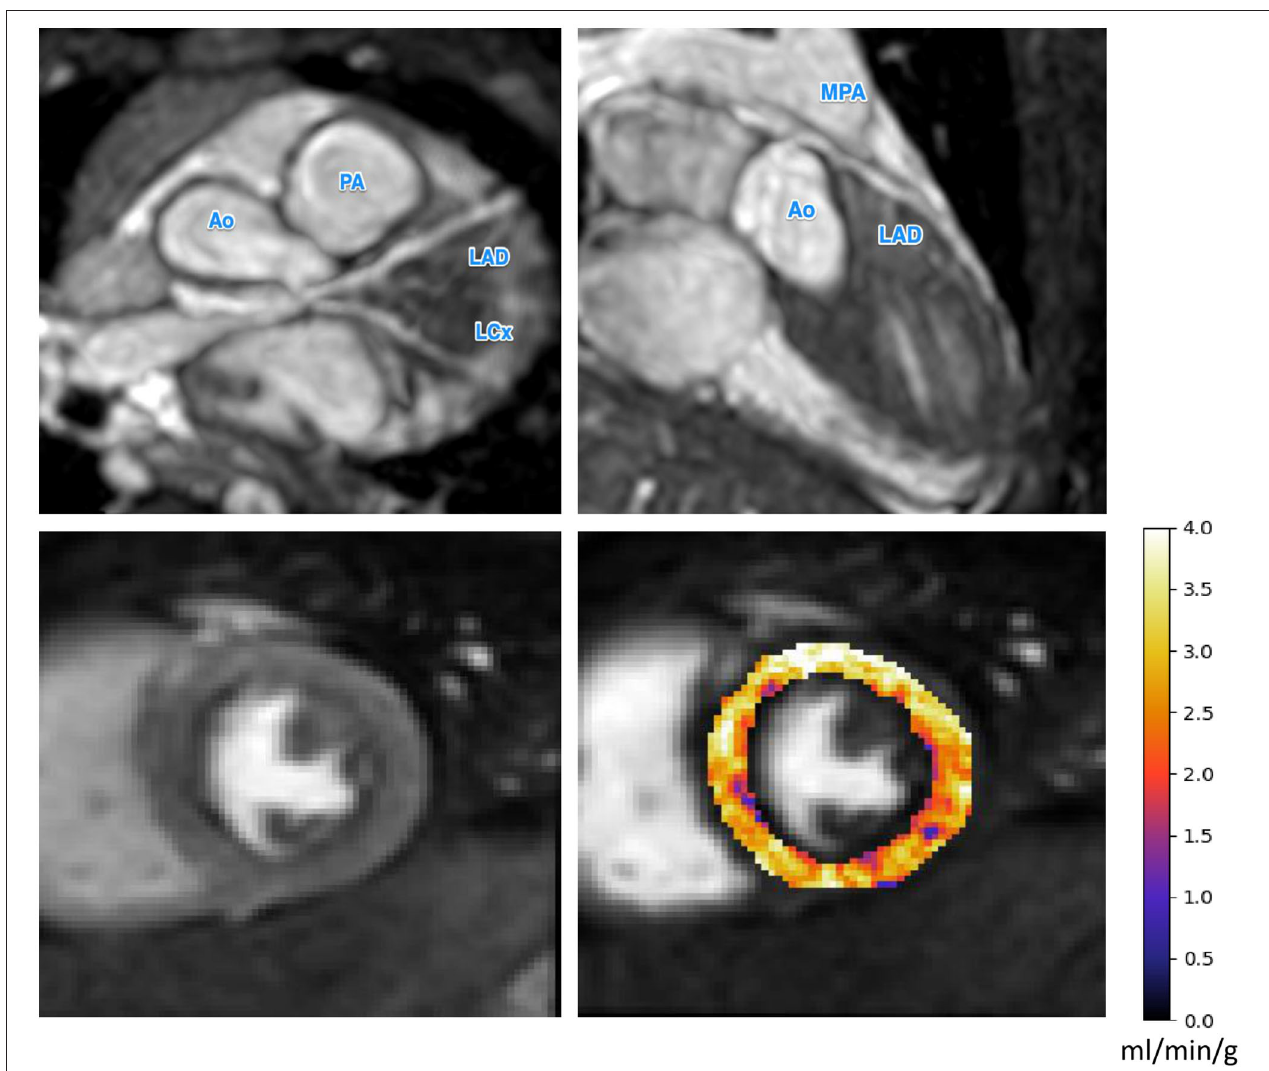
FIGURE 2 | The CMR angiography (top row) and stress perfusion CMR for a patient with a small left main coronary artery aneurysm. The small aneurysm does not seem to inhibit perfusion as reflected by the uniformly high MBF values. Ao, Aorta; PA, pulmonary artery; MPA, main pulmonary artery; LAD, left anterior descending artery; LCx, left circumflex